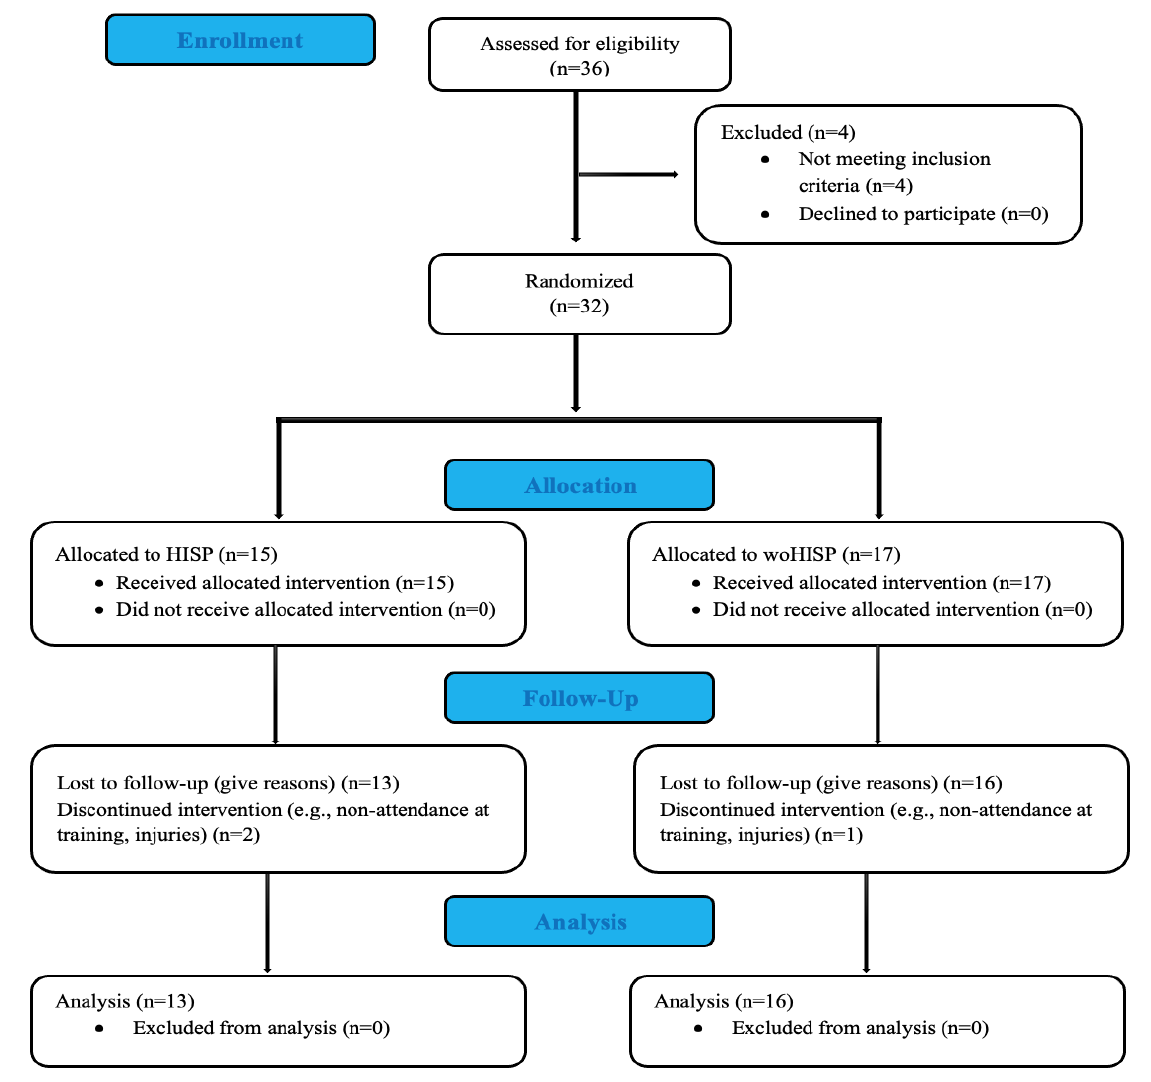
Figure 1. CONSORT flow diagram.